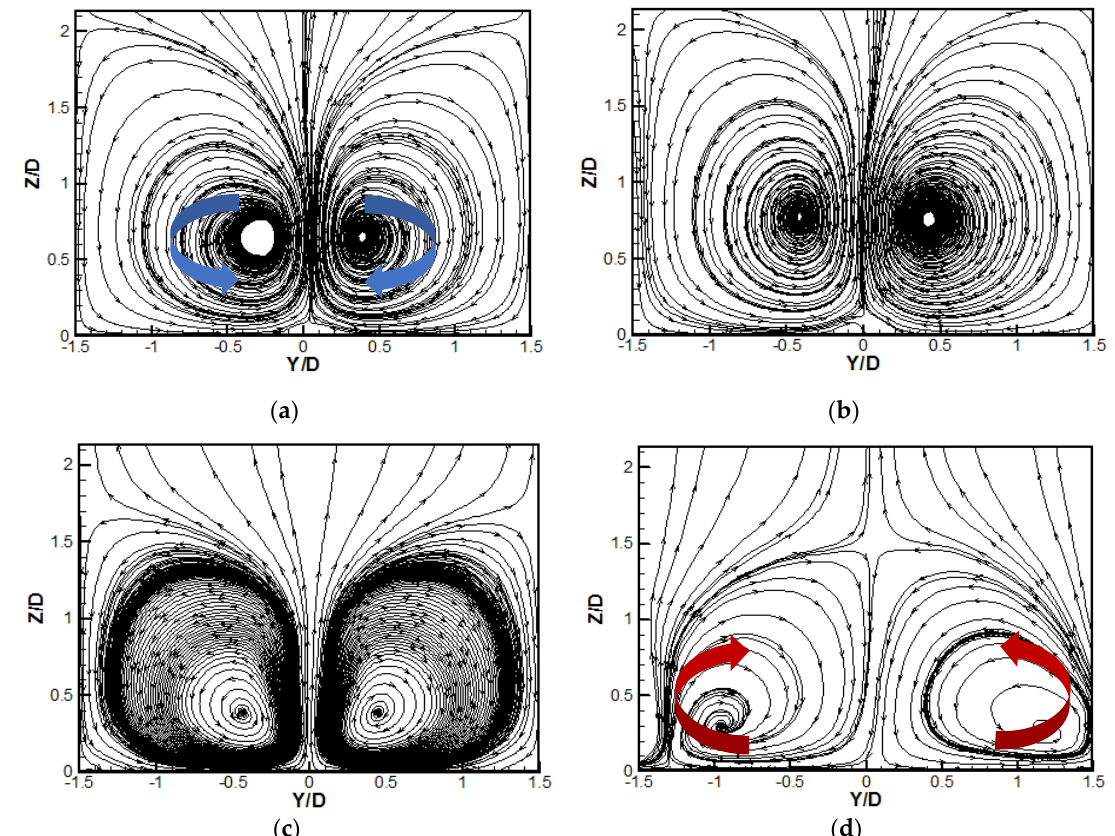
Figure 7. Streamline distributions over the surface X / D = 5 at M = 1.5. ( a ) CYL; ( b ) CIR_CRA; ( c ) CRA1; ( d ) CRA2.